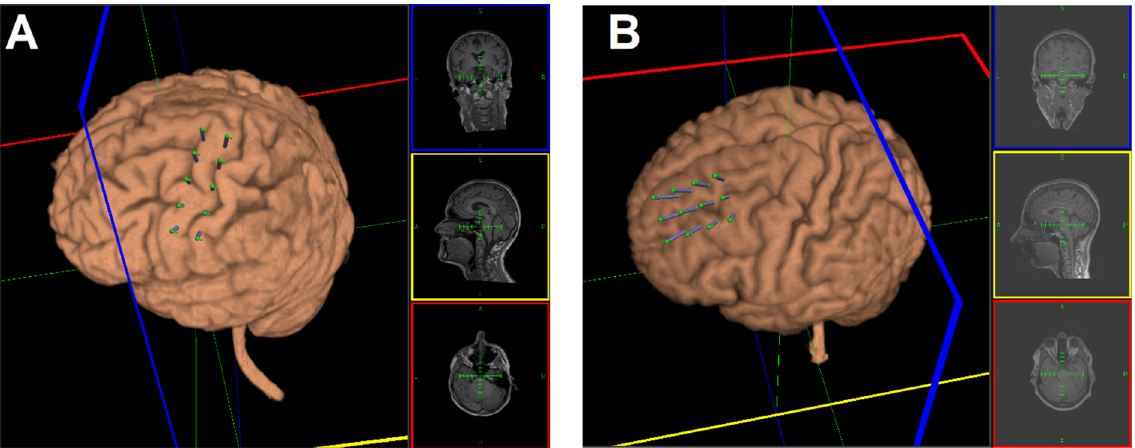
Figure 2. Target arrays for left M1 ( A ) and DLPFC ( B ) rTMS stimulation. The target grid for M1 was a 2 × 5 points array with a 10 mm interpoint distance. For the DLPFC, the target grid was a 3 × 4 points array with a 10 mm interpoint distance. For each participant, the target array was positioned based on anatomical landmarks.